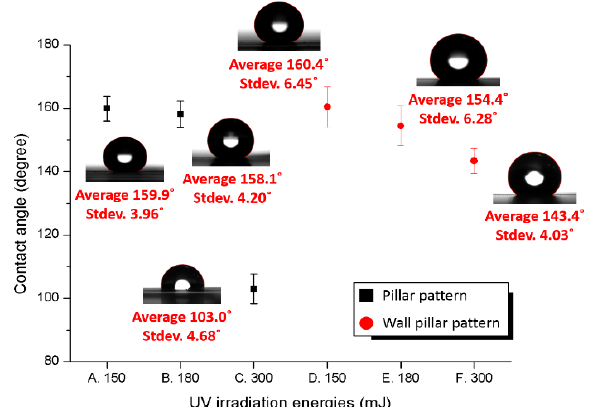
Figure 3. Micro-pattern deformation before and after tulip-shaped pattern imprinting process (variable: ultraviolet (UV) energy). ( a , b ) Hexagonal pillar array pattern morphology before experiments. ( c – e ) Hexagonal pillar array pattern mor- phology after experiments; UV irradiation energy: ( c ) 150 mJ, ( d ) 180 mJ, ( e ) 300 mJ. ( f , g ) Hexagonal wall-pillar array pattern morphology before experiments. ( h – j ) Hexagonal wall-pillar array pattern morphology after experiments; UV irradiation energy: ( h ) 150 mJ, ( i ) 180 mJ, ( j ) 300 mJ. Figure 4. Contact angle measurement results of imprint film according to UV irradiation energies.